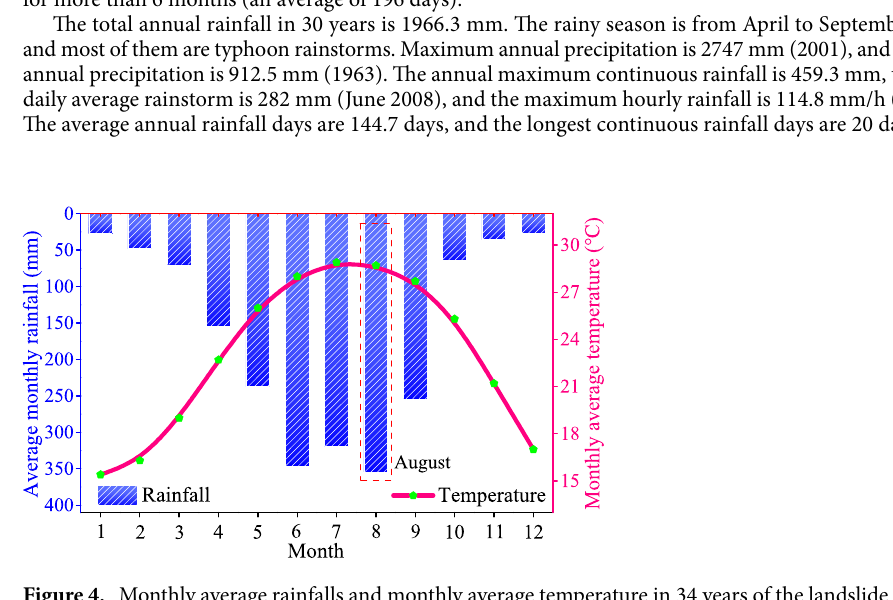
Figure 4. Monthly average rainfalls and monthly average temperature in 34 years of the landslide region (from 1981 to